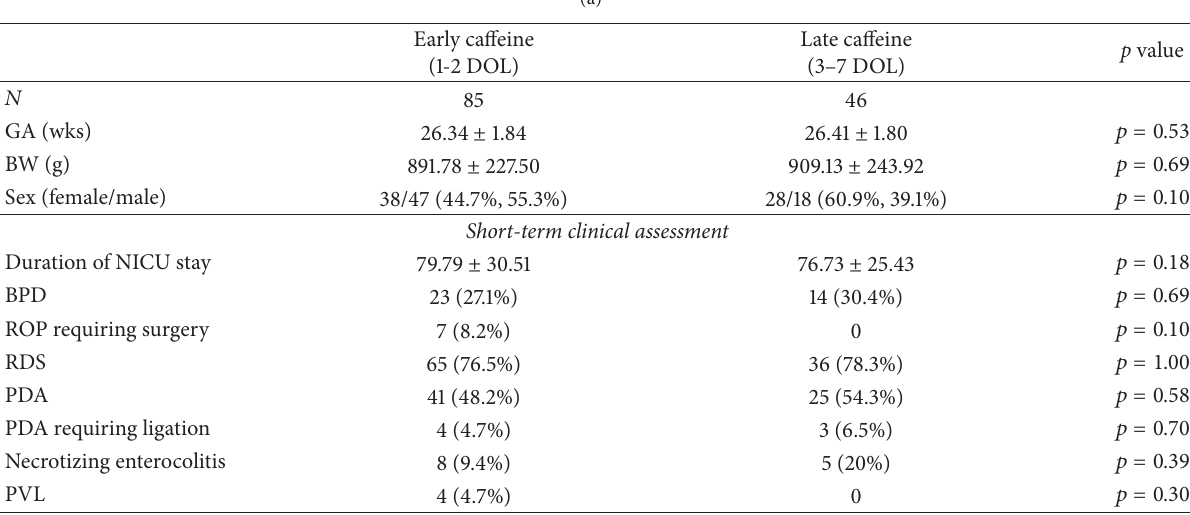
Table 2: (a) Neonatal outcomes of infants receiving early caffeine (1-2 DOL) and late caffeine (3–7 DOL). (b) Neonatal outcomes of infants receiving early caffeine (1-2 DOL) and very late caffeine ( ≥ 8 DOL). (c) Prediction of BPD and PDA ligation in infants with early caffeine (1-2 DOL) and very late caffeine ( ≥ 8 DOL) by multiple logistic regression